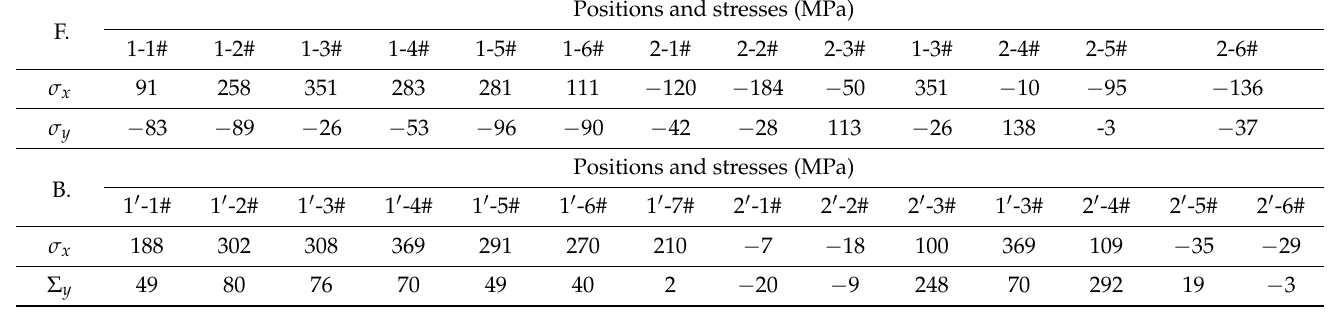
Table 3. Residual stress measurement results (F: front surface; B: back surface).